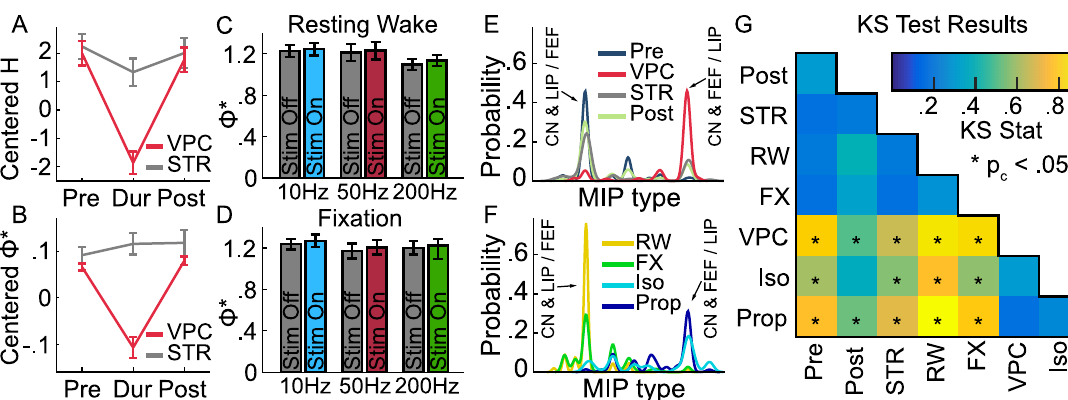
Fig 5. Measure of neural complexity and integration ( F � ) associated with consciousness selectively decrease during VPC, and integration patterns shift to reflect anesthetized rather than conscious states. A , Average entropy (H) and B , F � ( ± SE) centered relative to the fixation task for VPC and control stares relative to pre and post event conditions. C , D , Average F � ( ± SE) for stim-off (gray bars) and stim-on (colored bars) epochs at different frequencies excluding VPC for resting wake ( C ) and fixation ( D ) controls. E , F , Gaussian kernel-density estimates fitted to the probability distribution for the occurrence of different MIP types of the full system for ( E ) pre, VPC, control stare (STR), post, ( F ) resting wake (RW), fixation (FX), isoflurane (Iso), and propofol (Prop) conditions. G , Results for the KS tests comparing the MIP kernel-density estimates across all conditions. Color scales with the strength of the KS stat. � indicates corrected p-value (p c ) <